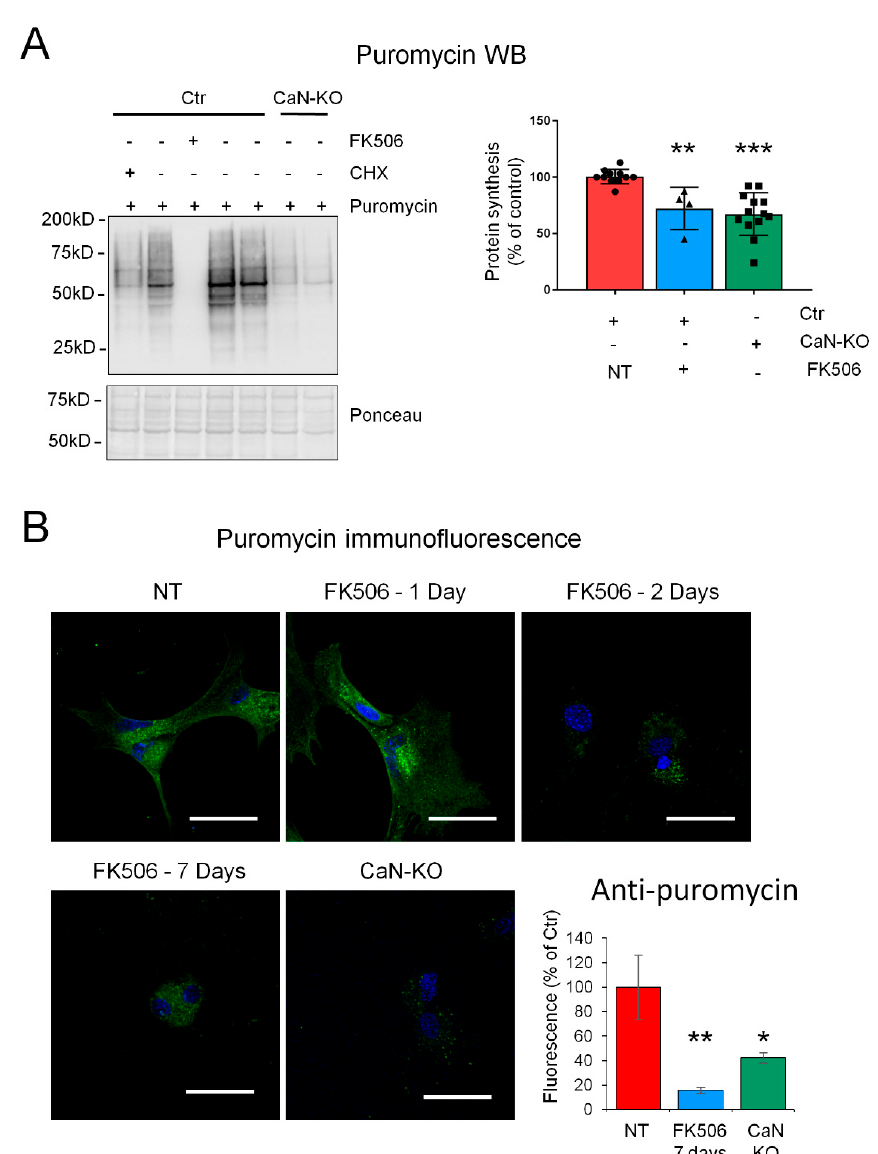
Figure 3. CaN inhibition permanently suppresses protein synthesis in cultured astrocytes. ( A ) Ctr and CaN-KO primary astrocytes were pulsed with puromycin for 3 h. Ctr were also treated with FK506 for 1 h to inhibit CaN activity. Where indicated, cycloheximide (CHX, 10 µ M) was added ten minutes before adding puromycin. Anti-puromycin antibody was used to detect neo-synthesized peptides. Ponceau staining was used for band normalization. Histogram shows quantification of anti-puromycin detected bands. Data are expressed as mean ± SD, 5, 4, and 11 independent cultures were used for Ctr, FK506 treated and CaN-KO samples, respectively. ** p < 0.01; *** p < 0.001, one way ANOVA with Tukey post hoc test. ( B ) Immunofluorescence images of Ctr, Ctr treated with FK506 (200 nM) for 1, 2 and 7 days and CaN-KO, stained with anti-puromycin antibody (green). Nuclei are stained with DAPI (blue). Bar, 25 µ m. Data are expressed as mean ± SD; * p < 0.05; ** p < 0.01, one way ANOVA with Tukey post hoc